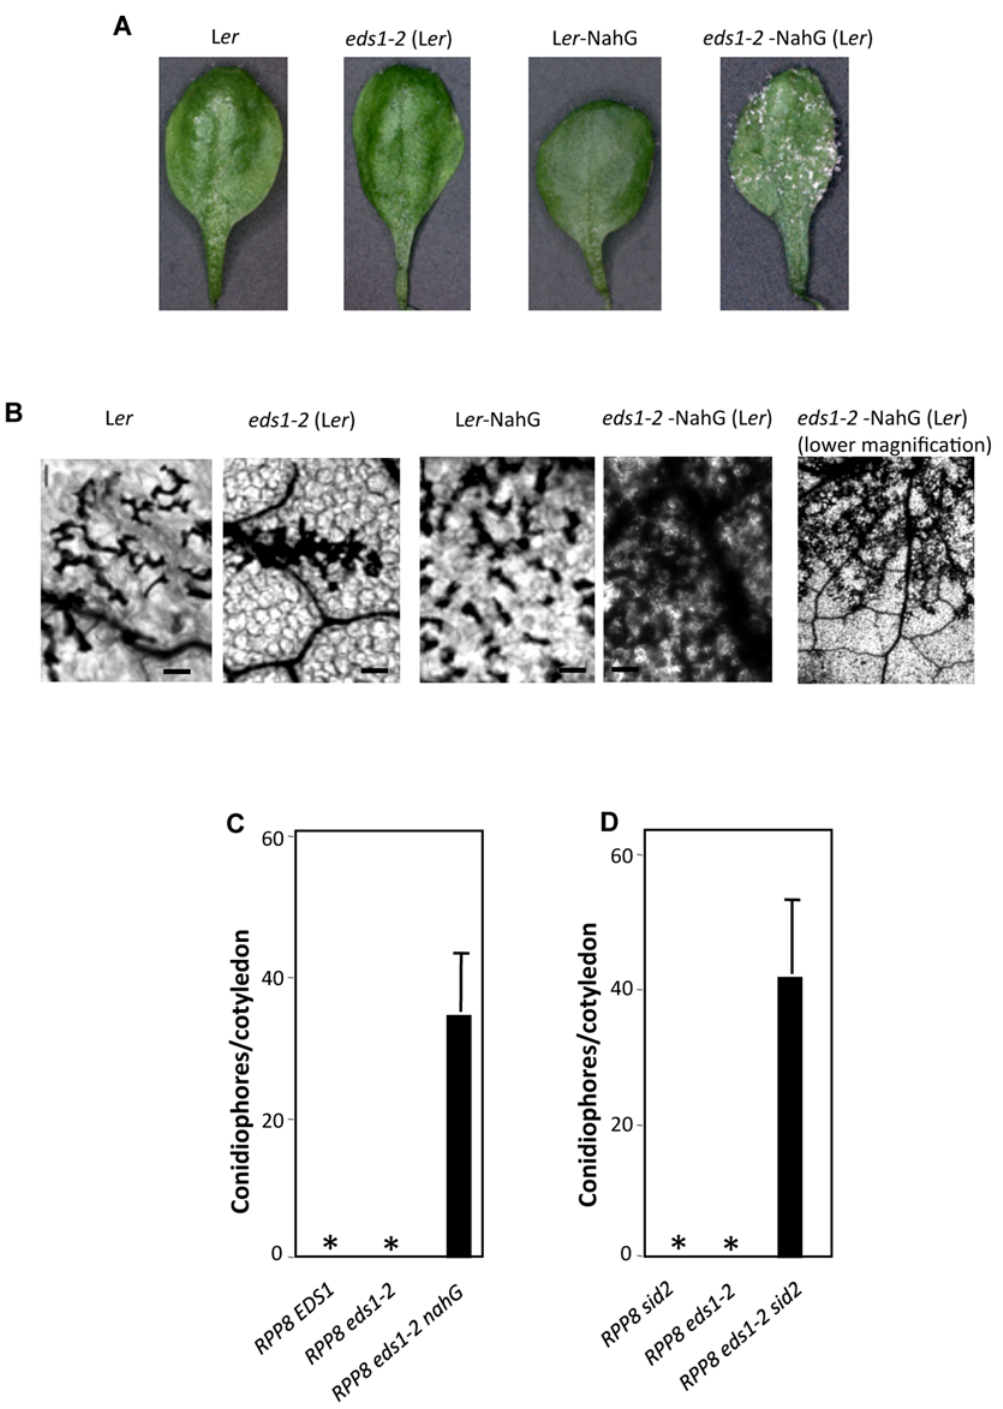
Figure 5. Interaction phenotypes of H.arabidopsidis biotype Emco5 expressing Atr8 with RPP8eds1-2nahG or RPP8eds1-2sid2-1 plants. (A) Whole leaf pictures showing growth of Emco5 on the cotyledons from indicated genotypes. All genotypes were in the L er background. Cotyledons were photographed 10 days after inoculation. (B) Trypan blue stained leaf showing microscopic HR on L er and L er nahG leaves, and trailing necrosis on eds1-2 and eds1-2 nahG leaves (scale bars, 270 microns). Both high (100 6 ) and low magnification (100 6 ) images of eds1-2 nahG leaf are shown. Pathogen inoculations were carried out in F2, F3, and F4 generations with consistent results. The F2 plants showing wt genotype at the mutant locus were resistant to pathogen infection (data not shown). (C) Quantification of pathogen growth on RPP8 EDS1 , RPP8 eds1-2 and RPP8 eds1-2 nahG plants. Approximately, 40–60 cotyledons were assayed for each genotype. Asterisks indicate absence of spores. All genotypes were in the L er background. (D) Quantification of pathogen growth on RPP8 sid2 , RPP8 eds1-2 , and RPP8 eds1-2 sid2-1 plants. All genotypes were in the ssi2 background. Approximately, 40–60 cotyledons were assayed for each genotype. Asterisks indicate absence of spores.